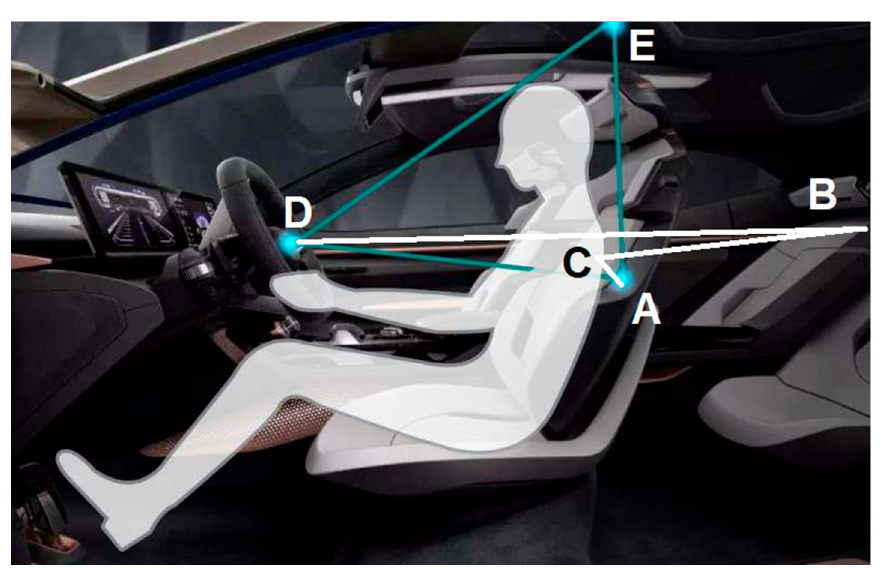
Figure 2. Multipath analysis diagram.